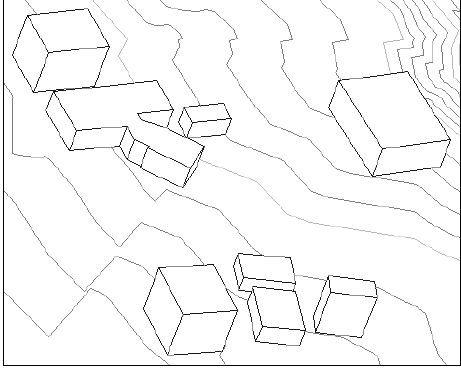
Fig 7 . 3D city model presented in linear-horizontal terrain surface display